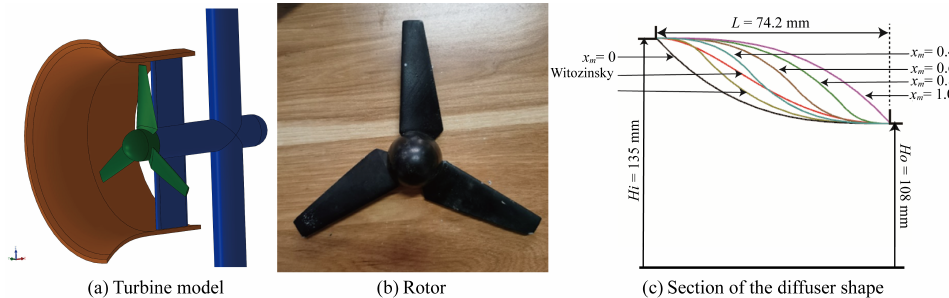
Figure 1. Sketch and image of the turbine and diffuser